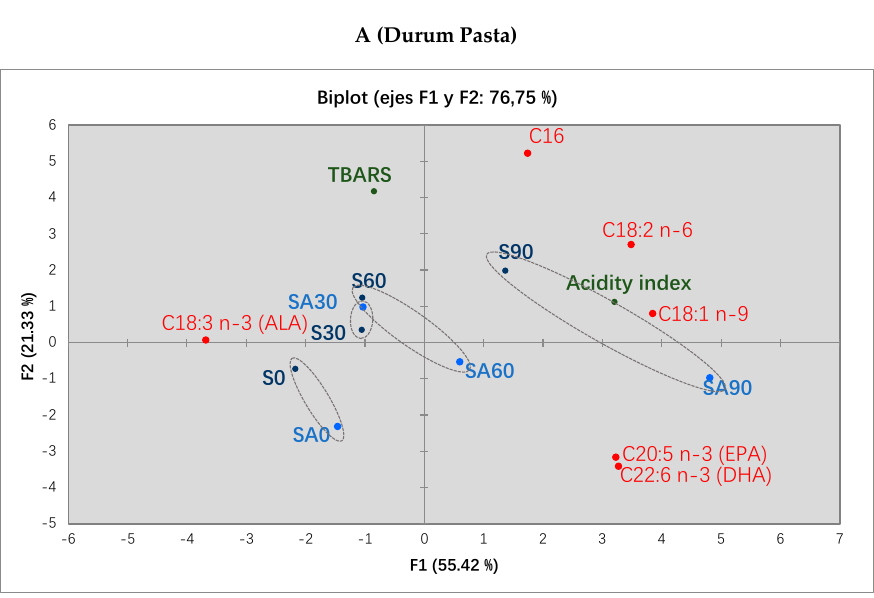
Figure 3. Optimal cooking time for both types of pasta. Distinct letters indicate significant differ- ence ( p < 0.05) among the cooking times for each kind of pasta.